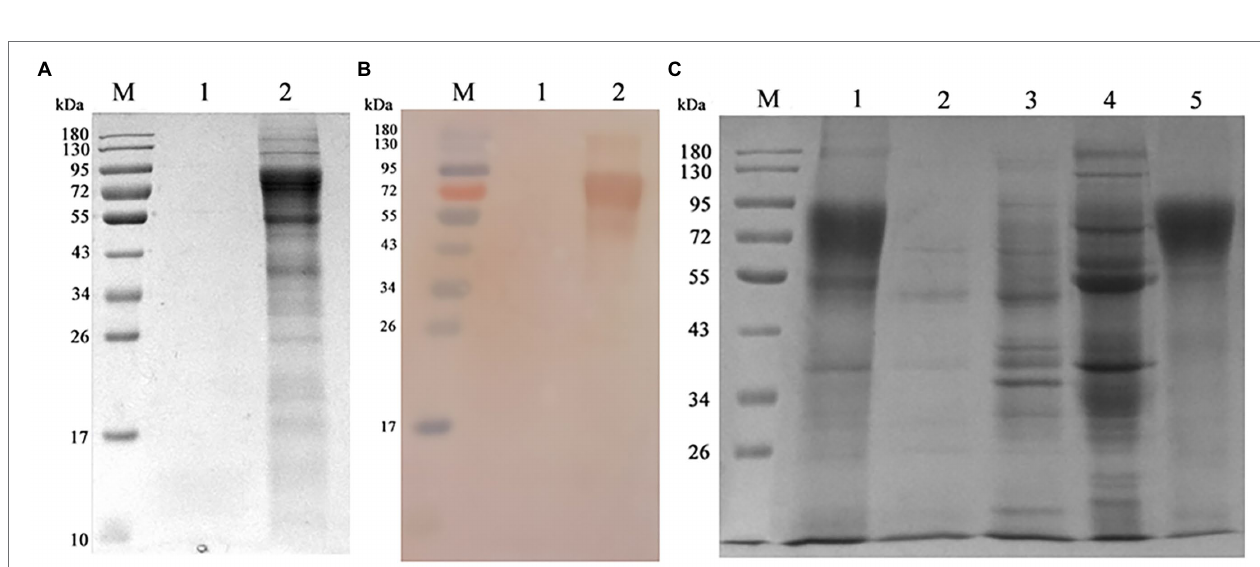
FIGURE 3 | The fluorescence (A) and cells (B) of Chinese hamster ovary (CHO)-gE cell line.